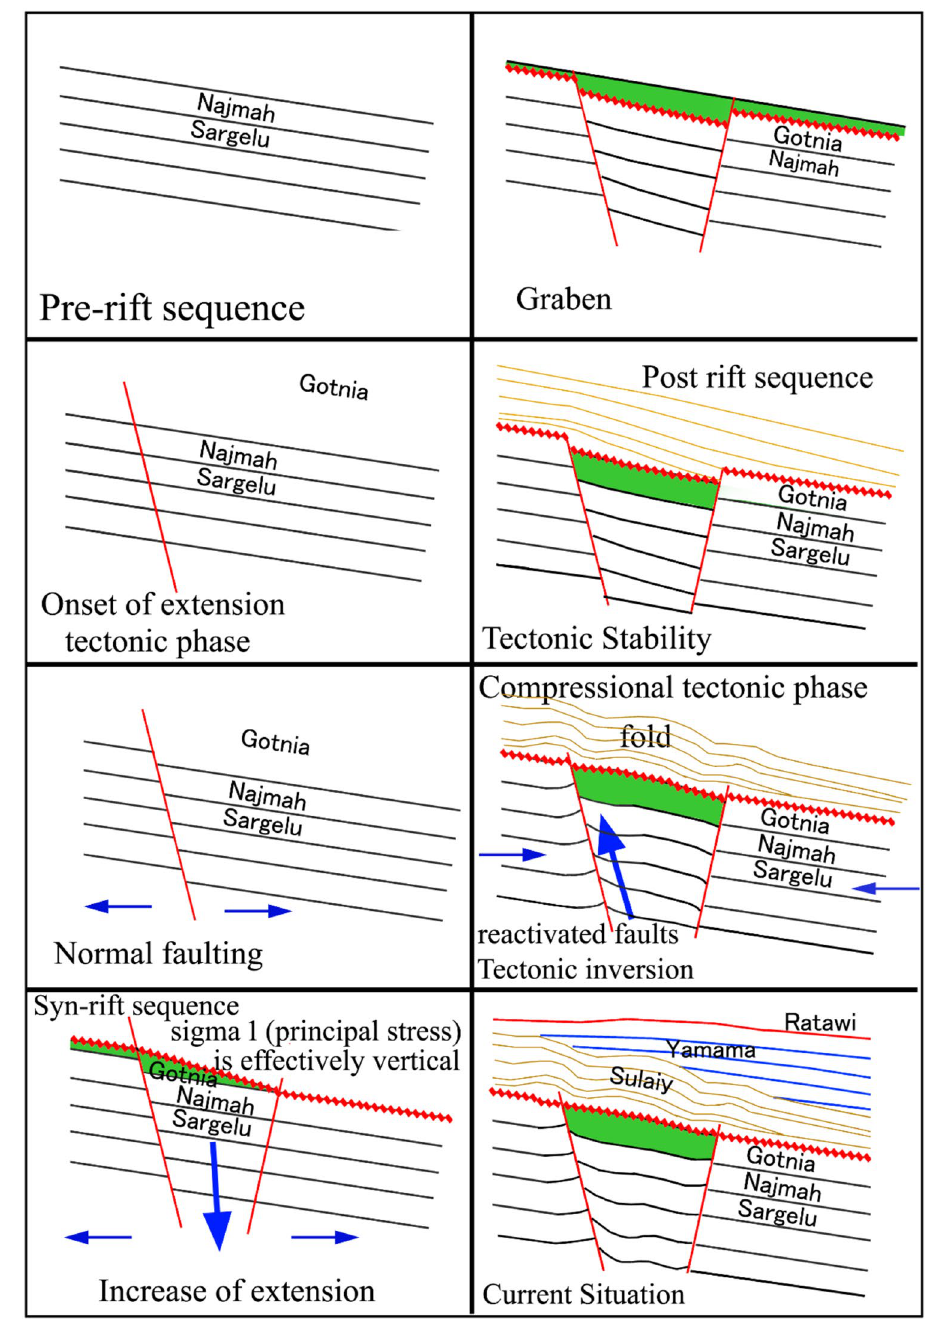
Fig. 13 Revolutionary scheme illustrates the tectono-strati- graphic stages of Jurassic suc- cession in the Merjan